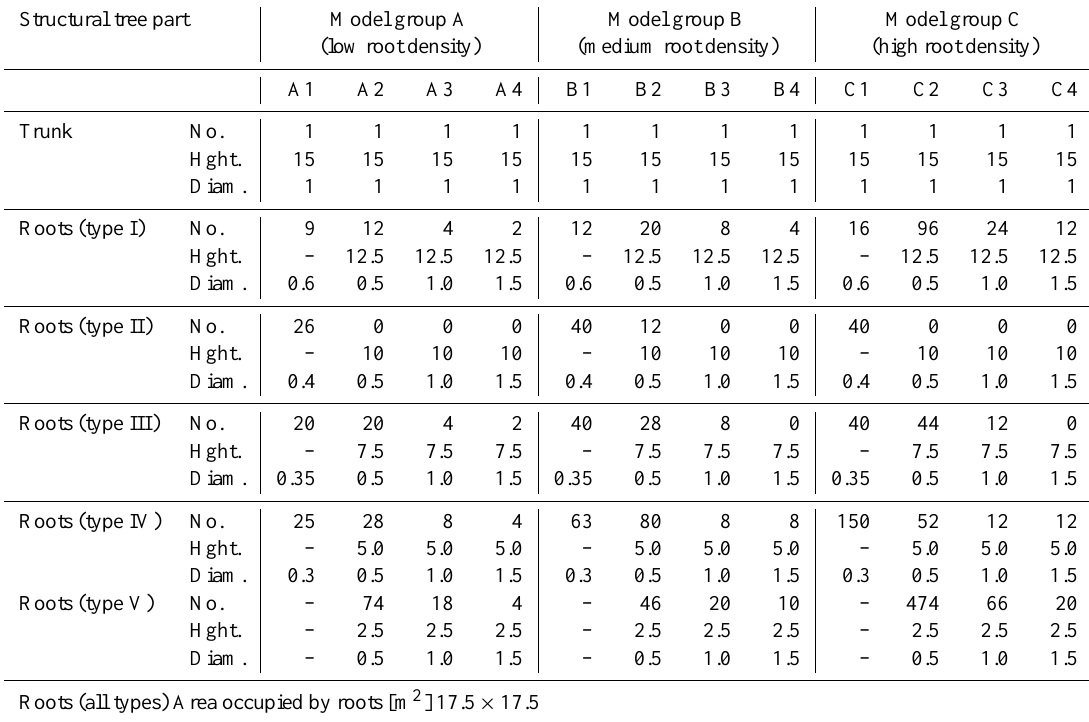
Table 2. Influence of model submergence depth on the parameters of “real” and parameterized mangrove models (scale 1 : 20) (see also Fig. 2 and Figs. A1–A3 in Appendix